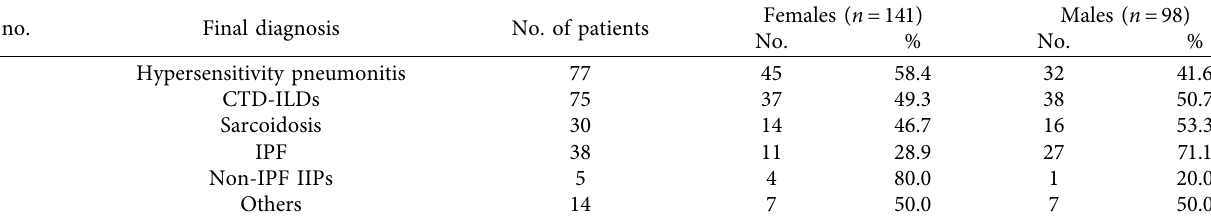
Table 2: Distribution of subjects according to diagnosis.